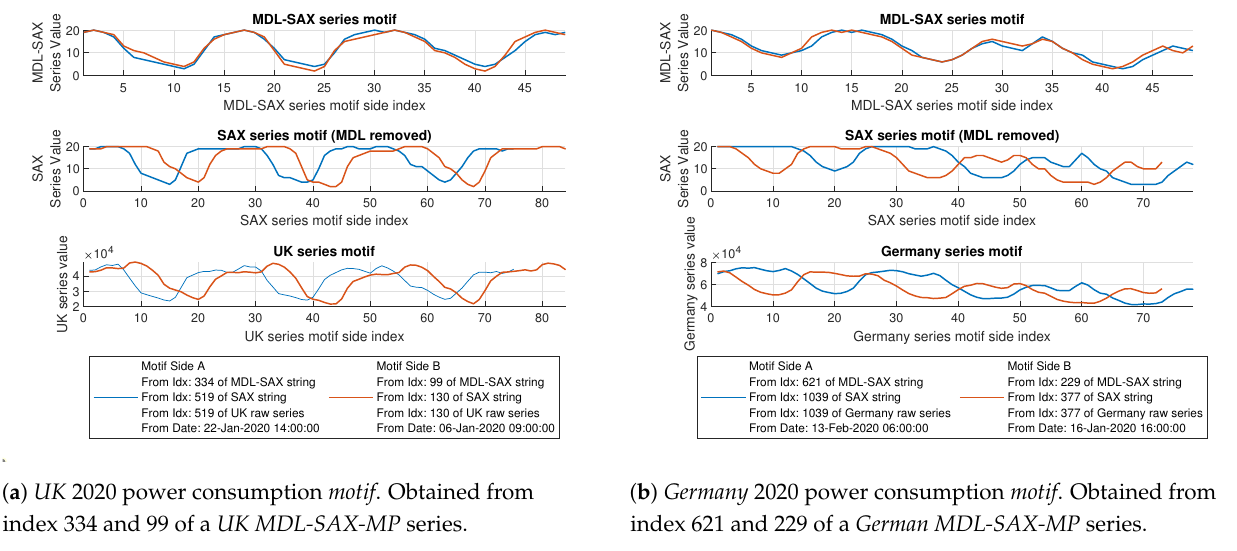
Figure 12. Sample motifs identified by SLIM in 2020 UK and Germany hourly power consumption